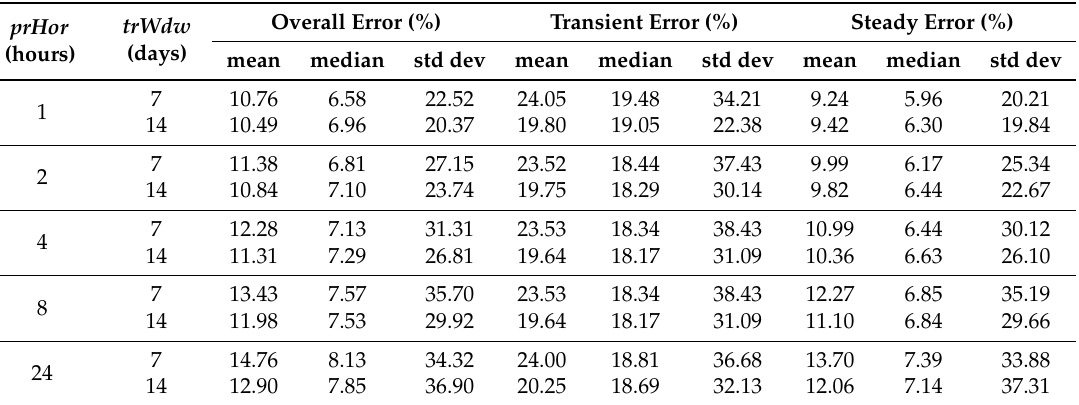
Table 3. Sensitivity analysis on training window size